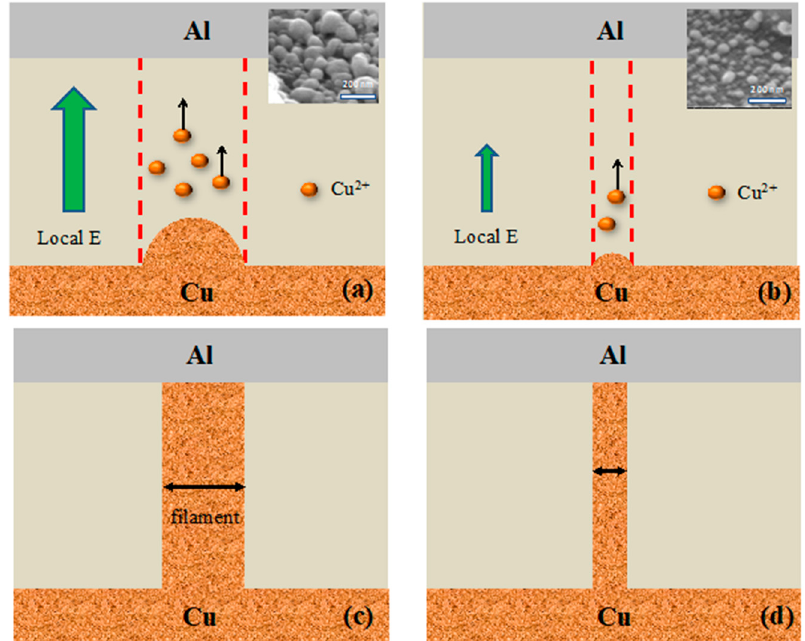
Figure 4. Schematic model of filament formation during the Forming operation for the samples obtained using a ( a ) long (CDT 90 s) and ( b ) short (CDT 60 s) displacement time, and the formed Cu filament after Forming operation of the ( c ) CDT 90 s and ( d ) CDT 60 s sample. Inset: SEM images of the sample surfaces.